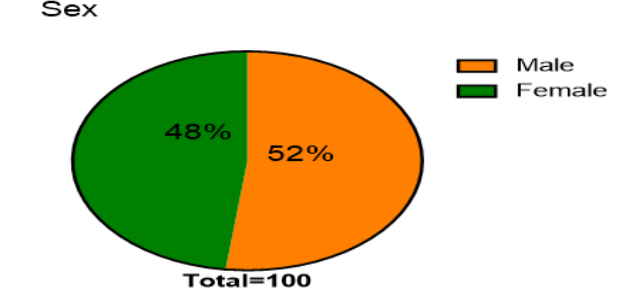
Figure 1. Frequency distribution chart of the samples studied by